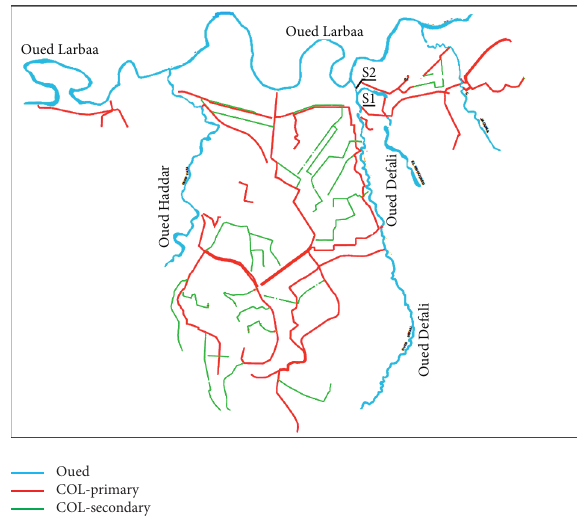
Figure 2: Sites S1 and S2 geographic location. Table 2: Physicochemical parameters analysis